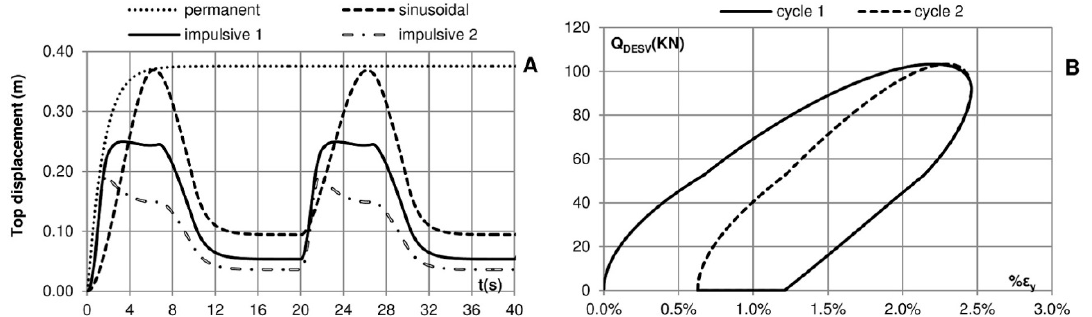
Figure 14. ( A ) Movements on the top of the crown wall; ( B ) stress–strain graph showing the relationship between the load deviator and vertical deformation produced in the first and second cycles of loading.